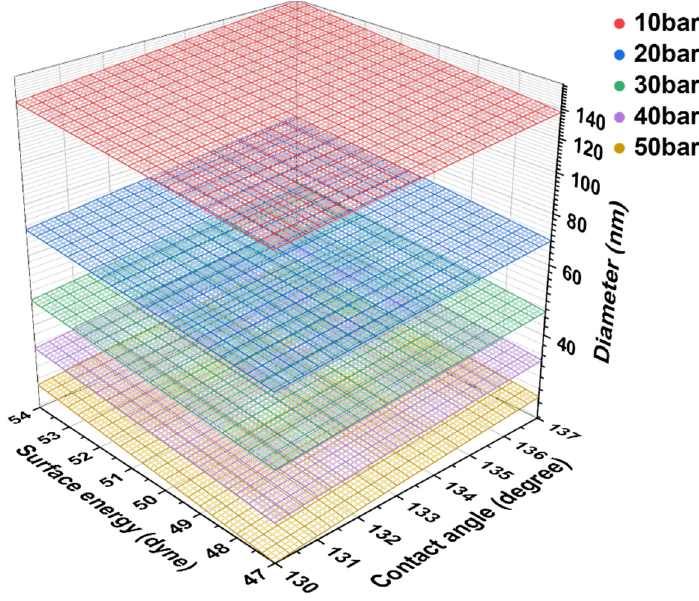
Figure 4. Calculated minimum impregnatable pore size ranges of the graphite block at various im- pregnation pressures.